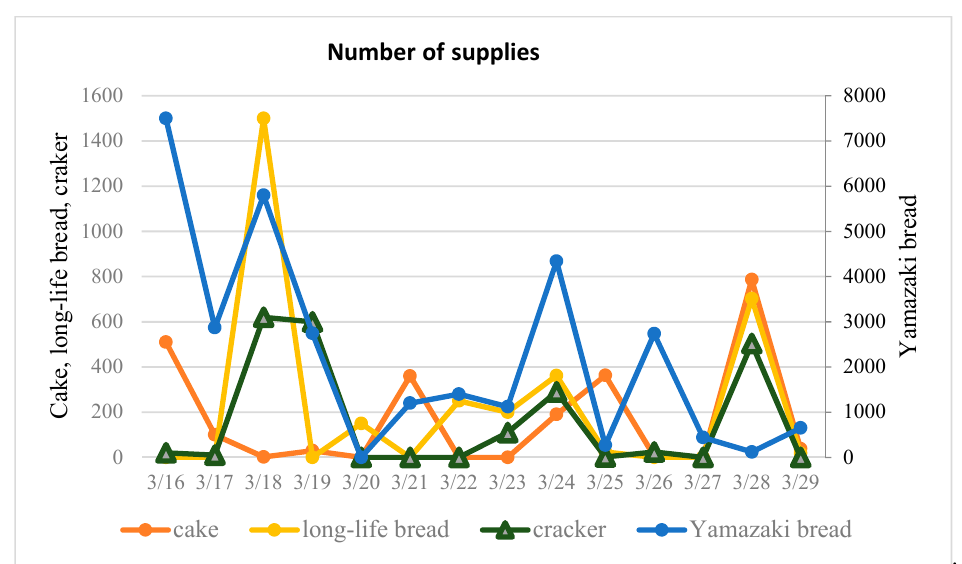
Figure 4. Supply of wheat-based commodities.